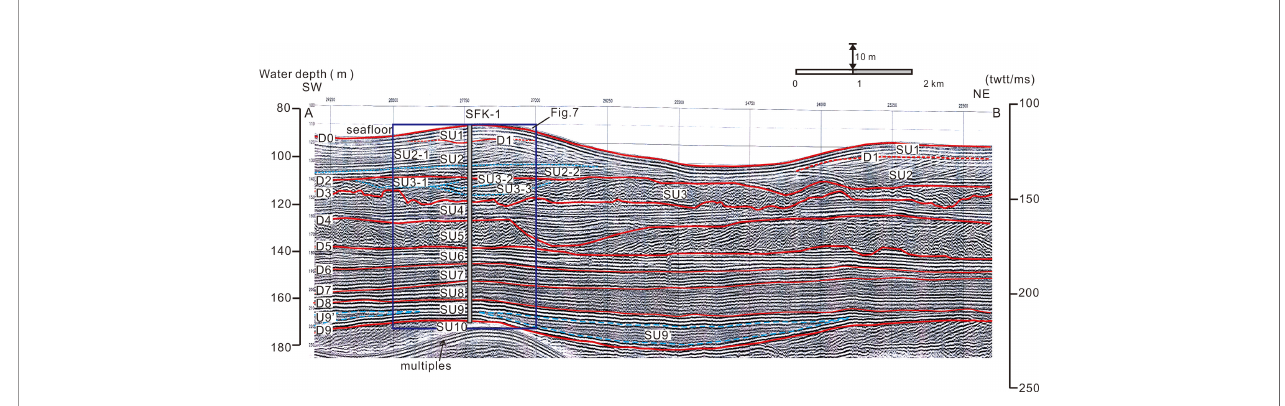
FIGURE 2 | The (A, B) section of the high-resolution seismic pro fi le across boreholes SFK-1 and DZQ4. The schematic interpretation is partly modi fi ed after Wang et al. (2013; 2014). The red solid and blue dotted lines are the boundaries of depositional units and subunits respectively. SU indicates seismic units, and D denotes the discontinuity or depositional